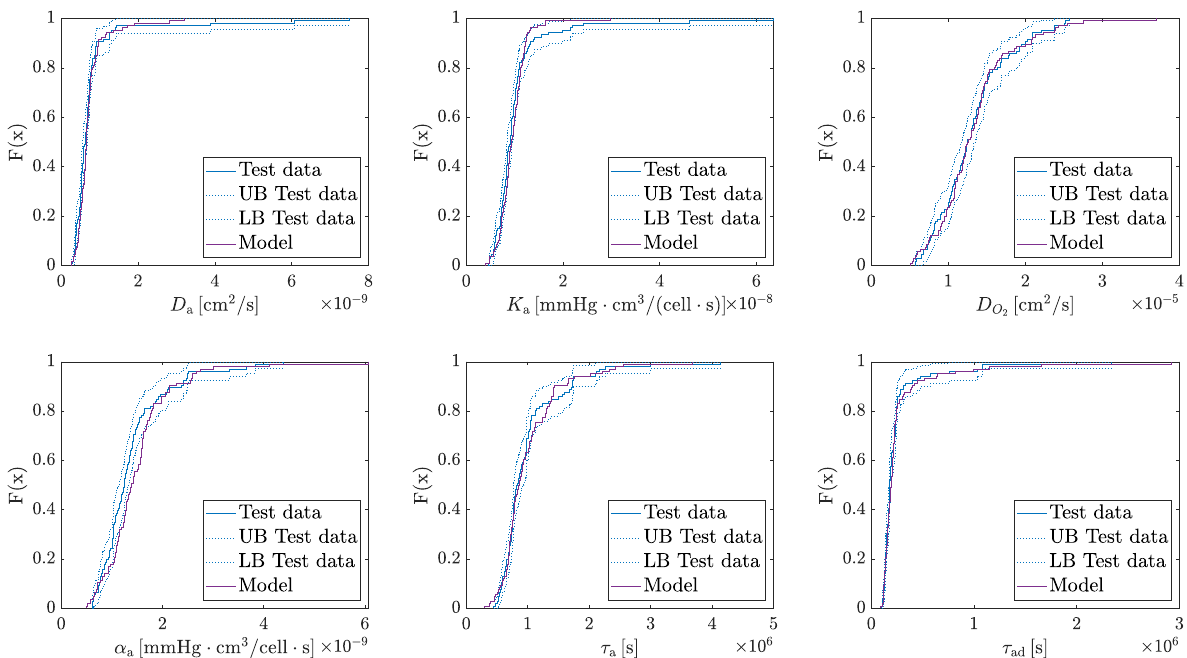
Figure 5. Empirical cumulative distribution functions (ecdf) of the test data for each